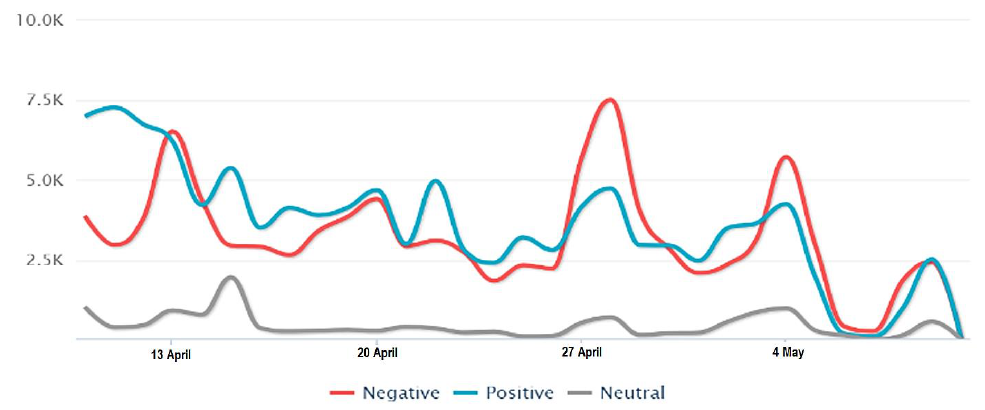
Figure 3. Trends on sentiments in discussions on LSSR.